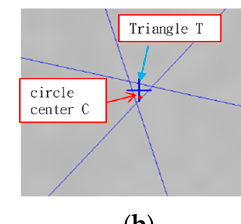
Figure 1. The inspection system is divided into three parts. Turntable simulation in the production line. Subsystem 1 displays the status of dynamic capture. Subsystem 2 displays the results of the geometric inspection.